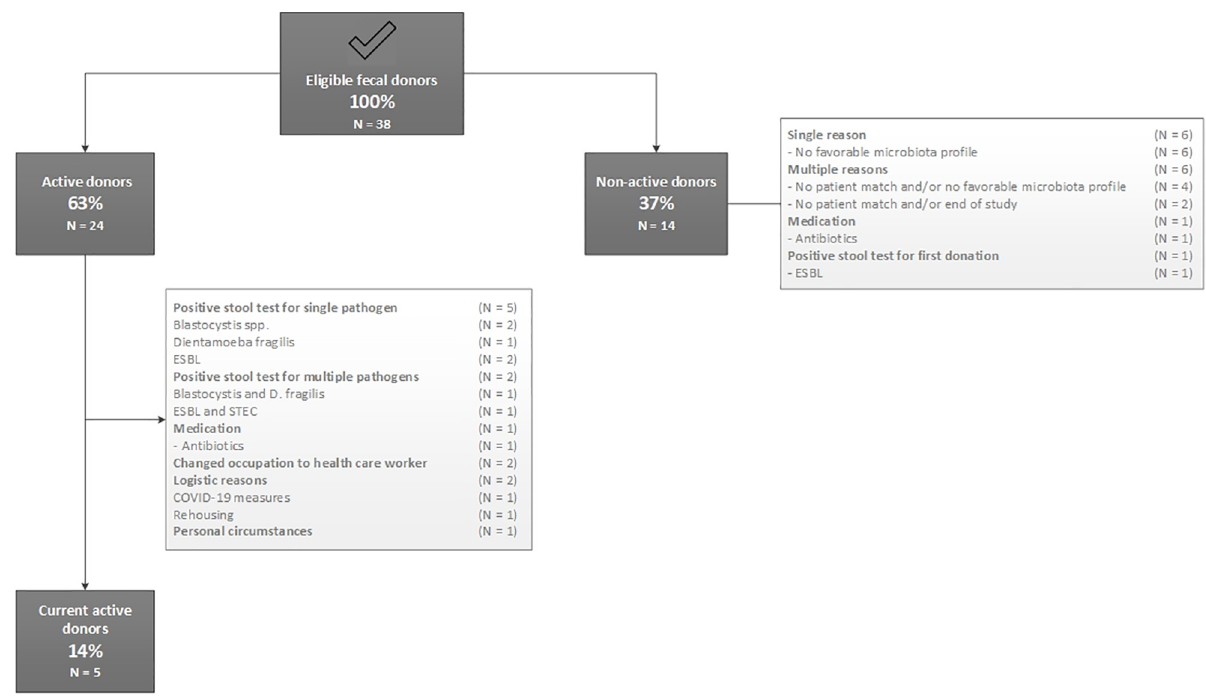
Fig 2. Flow diagram of follow-up of eligible